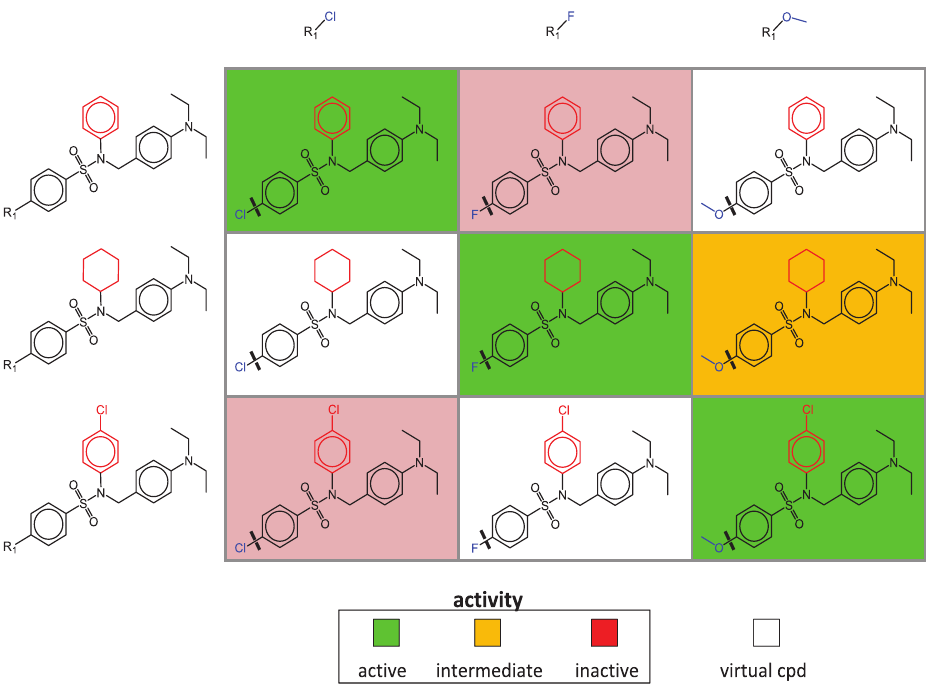
Figure 1. SAR matrix. A schematic representation of a SARM is shown. Compound fragmentation (indicated by thick lines in matrix cells) yields three analog series with structurally related cores (keys). Each series consists of analogs that share a core and differ by a single substituent (value, blue). Structural differences between the cores of the three series are highlighted in red. Each SARM combines all analog series with structurally related cores available in a compound set. Rows and columns represent compounds sharing the same core and substituent, respectively. In each cell, the combination of a core and a substituent defines a unique molecular structure. Compounds present in the data set are represented by filled cells that are color-coded according to activity. In addition, empty cells represent virtual compounds (i.e., previously unexplored key-value combinations resulting from MMP